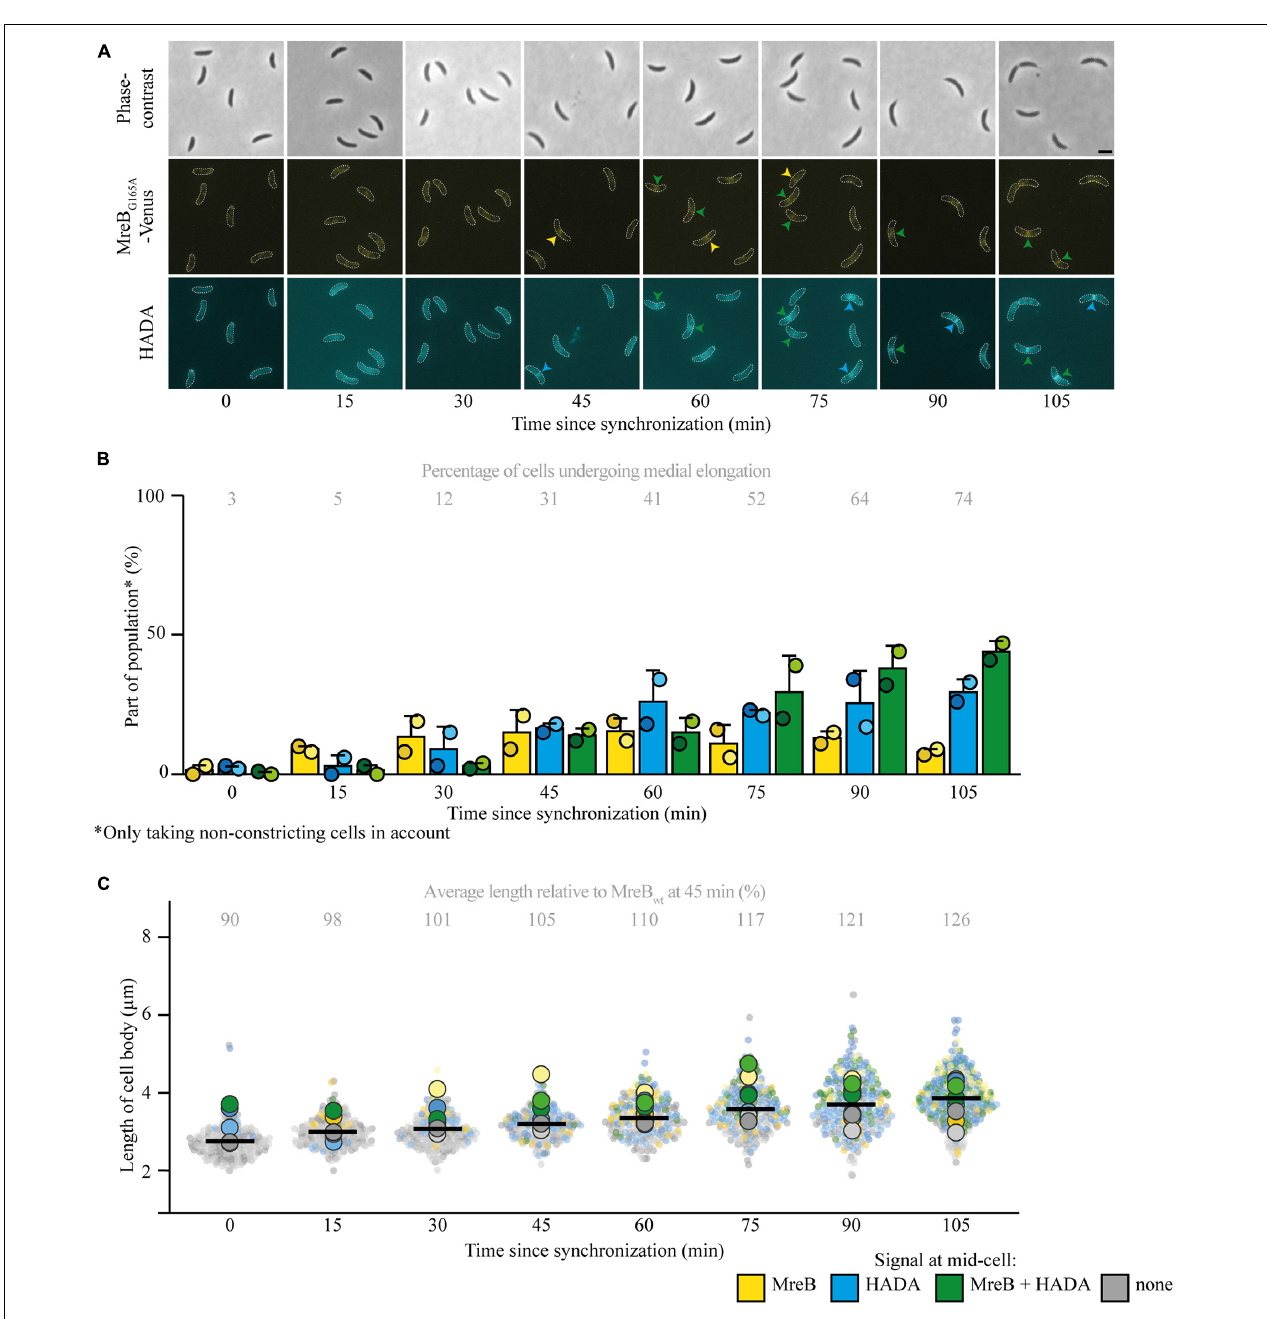
FIGURE 2 | Medial elongation can precede MreB accumulation at midcell in a strain with delayed MreB recruitment. Light microscopy images (A) and respective quantification (B) of strain JAT790 (P mreB - G165A mreB P xyl - venus- G165A mreB ) grown for the indicated duration after synchronization, stained with a short pulse of HADA show that medial elongation commences in the absence of MreB at midcell in part of the population. Cells in the representative images (A) are outlined and midcell localization is indicated by arrowheads: colocalizing MreB and HADA are indicated in green, only MreB in yellow, and only HADA in blue. Quantification of fluorescence signals (B) at midcell (using the color scheme outlined above) was performed on 100 non-constricting cells per replicate for two replicates per timepoint (value for each replicate is indicated by circles, replicate 1 is shown in a darker shade and replicate 2 in a light shade). Bars indicate the average of two replicates and error bars indicate standard deviation. In addition, the average percentage of non-constricting cells showing HADA (either in presence or absence of MreB) is given for each timepoint. Analysis of the length of cell bodies (of both constricting and non-constricting cells, in total at least 100 cells per replicate) shows that cells become longer with time and cells that are incorporating HADA are relatively longer (C) . Cell lengths are shown in superplots, where each small dot indicates the value for a single cell. The color of each dot follows the color scheme outlined above, in order to identify differences in cell length for the different subpopulations, and shows different shades to differentiate between the replicates. The large dots show the average cell length for each localization subpopulation per replicate. The horizontal black bar indicates the average length over all cells and the numbers above the graph express this average length as a percentage of the average length of the cells carrying MreB wt after 45 min (strain MT309, indicated in Figure 1